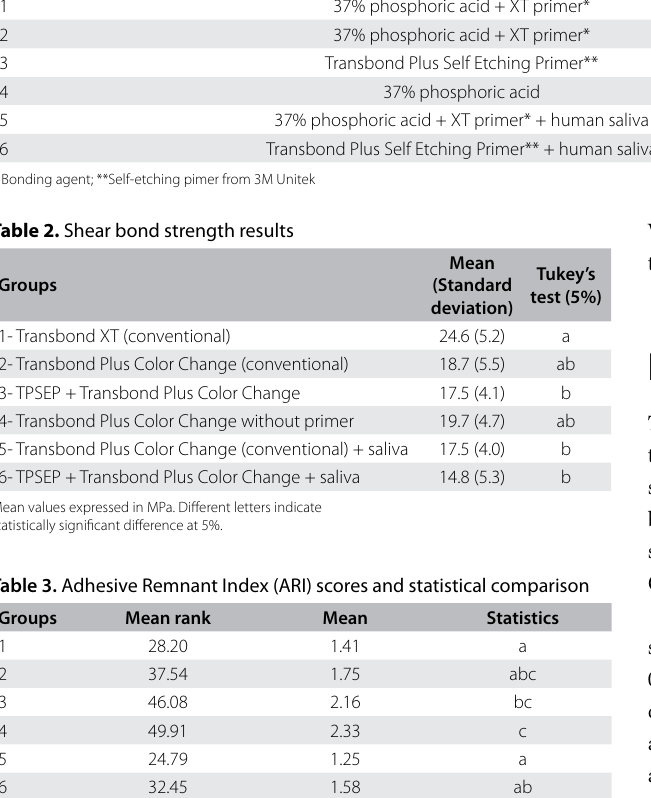
Different letters indicate statistically significant difference at